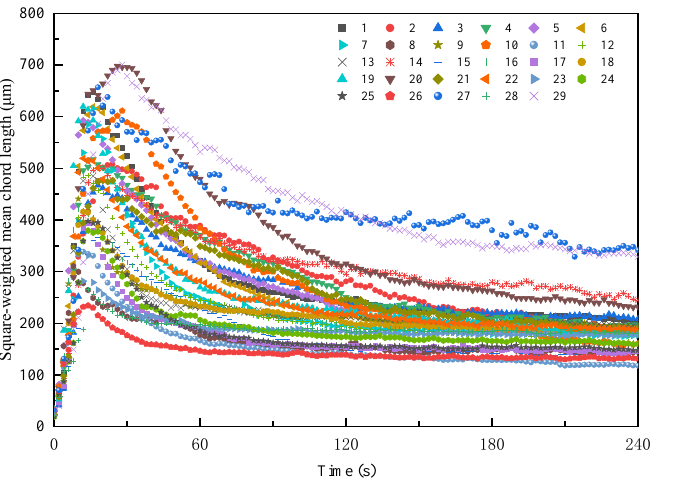
Figure 2. Dynamic evolution of the square-weighted mean chord length of floc with flocculation time [25].